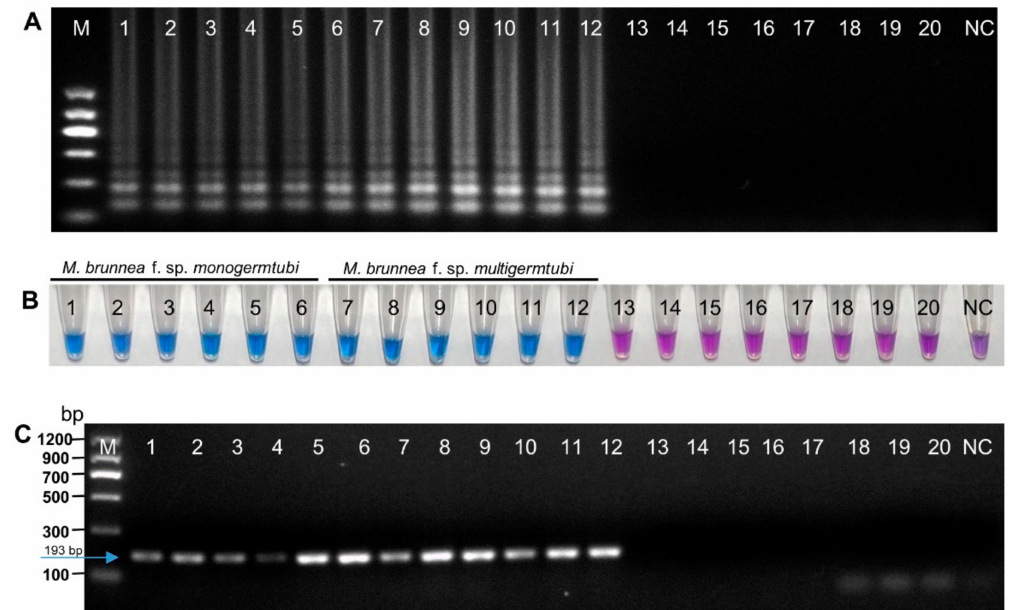
Figure 3. Specific detection of M. brunnea by the LAMP and PCR assays. ( A ) LAMP assay products visualized by agarose gel electrophoresis. ( B ) LAMP assay products visualized by hydroxynaphthol blue (HNB). ( C ) PCR assay products on agarose gel. Lanes and tubes 1–6 are M. brunnea f. sp. monogermtubi strains (QC2, QM2, QM3, QM6, QM8, and QM15, respectively); lanes and tubes 7–12 are M. brunnea f. sp. multigermtubi strains (J1, J3, 214-2, 214-4, XY-1, and XY-3, respectively); and lanes and tubes 13–20 are other tested fungi ( M. coronaria Mp-1, M. rosae Ms-3, Melampsora larici-populina YL-1, Venturia populina T4, Elsinoë australis NL-1 , Alternaria sp. As-1, Botryosphaeria sp. Bs-1, and Pseudocercospora sp. Ps-1, respectively). NC = negative control (no DNA); M = molecular size